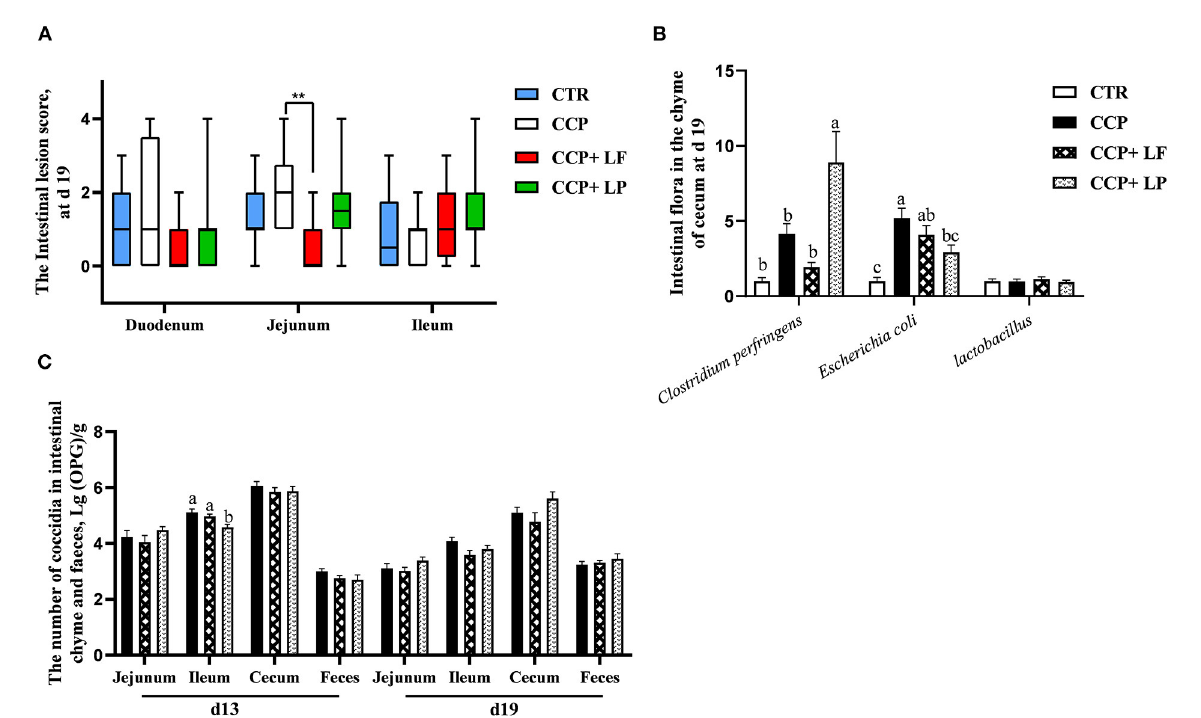
FIGURE3 The intestinal lesion score, the number of cecal bacteria, and intestinal coccidia. The data of the intestinal lesion score is arranged in (A) ( n = 12), the levels of some bacteria in the cecal chyme are shown in (B) ( n = 10), and the numbers of coccidia in the chyme are arranged in (C) ( n = 12 in the chyme of jejunum, ileum, and chyme. n = 6 in the feces). The data in (A) were expressed in the median and interquartile range, and data in (B,C) were presented as mean ± standard error. CTR, the control group; CCP, the group coinfected with coccidia and C. perfringens (CCP), CCP + LF and CCP + LP denote the groups fed Lactobacillus fermentum - and Lactobacillus paracasei -supplemented diets with CCP challenge. In (A) , ** = 0.001 < P < 0.01, among (B,C) , a,b, and c indicate that the different pillars without common superscripts differ significantly ( P <